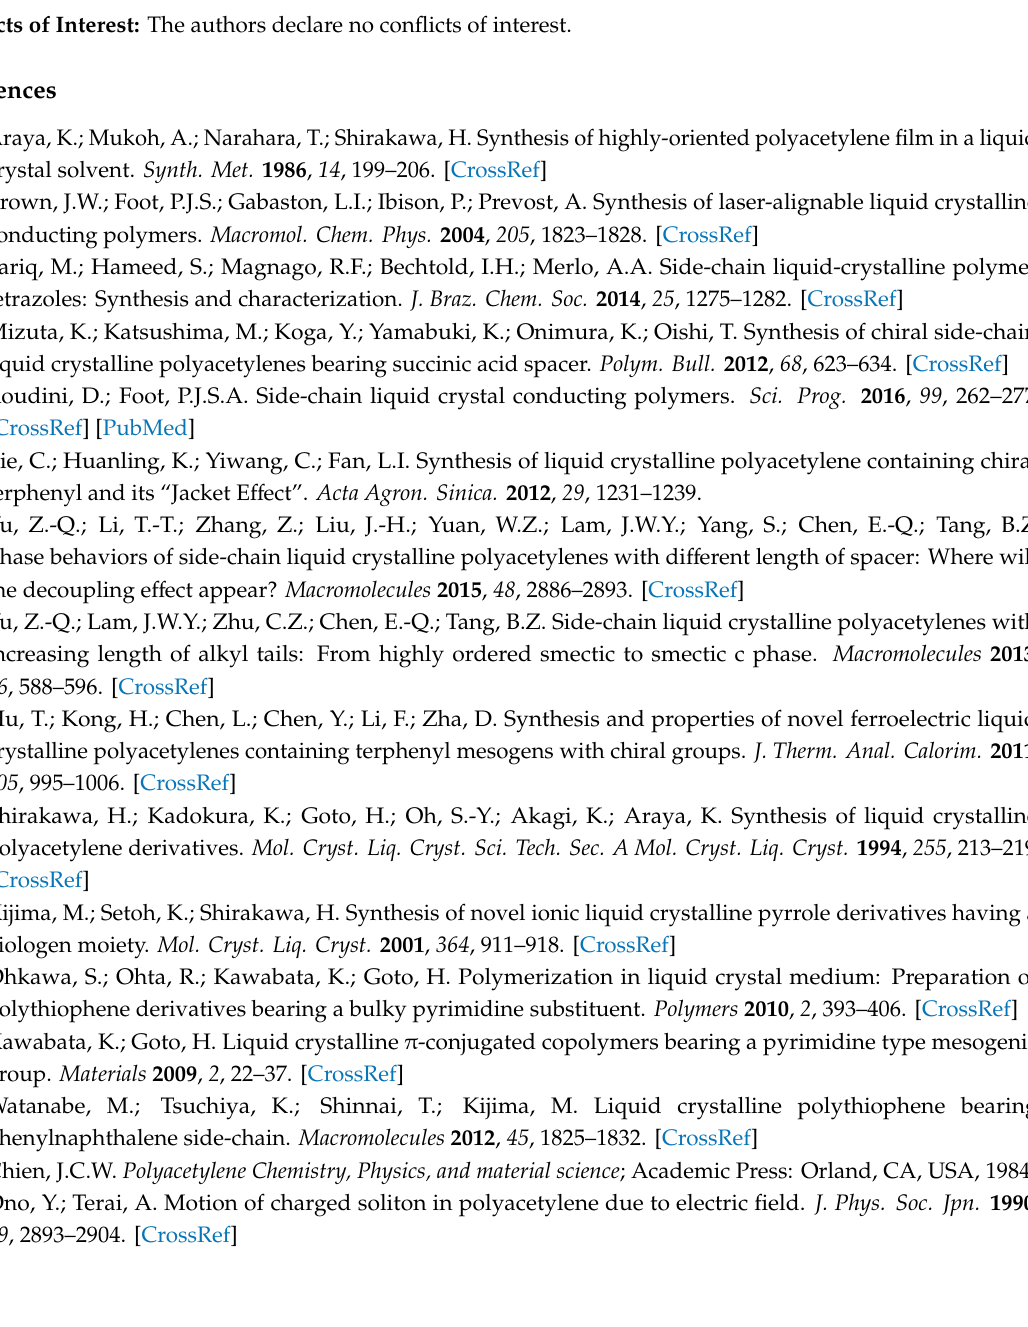
Figure S1: Optical rotatory dispersion spectrum of SmC*–LC–poly(Ac–Pyr) blend. Inset shows linear dichroism of the blend film (red